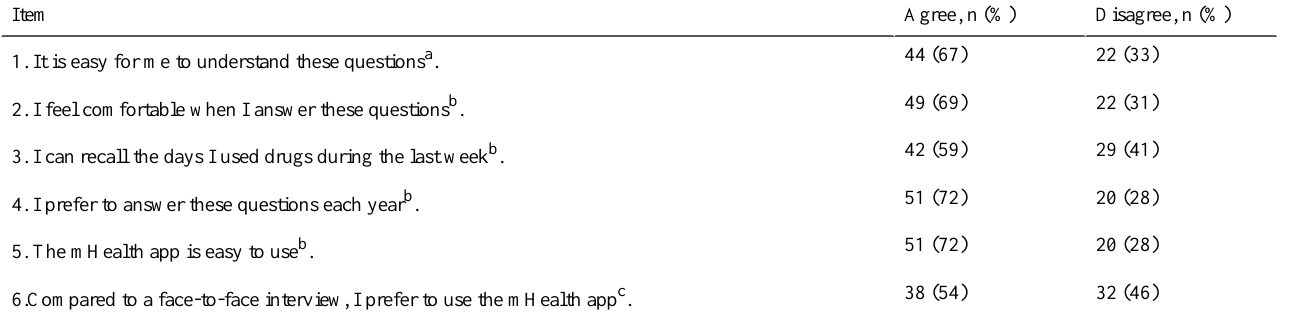
Table 4. Post-intervention survey